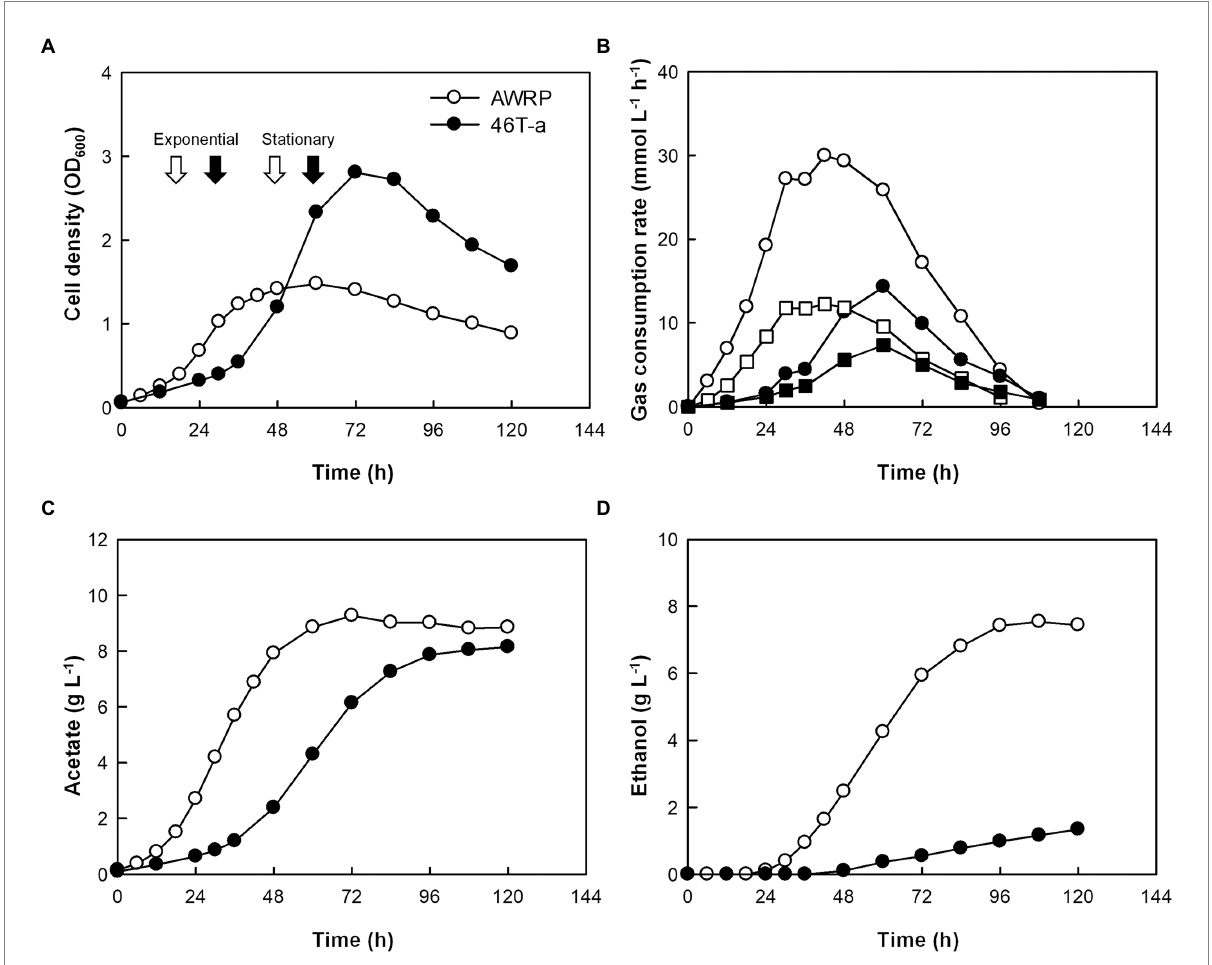
FIGURE 2 Batch fermentation profiles of AWRP (open symbols) and 46 T-a (closed symbols) without exogenous acetate. All fermentations were conducted in duplicate with continuous gas feeding and pH control. Average values of cell growth (A) , gas consumption rate (B) , acetate (C), and ethanol (D) production are shown. Samples for transcriptome analysis were taken at time points indicated by arrows in panel A . The squares and circles in panel B indicate the CO 2 and H 2 consumption rates, respectively. See Supplementary Table S3 for individual